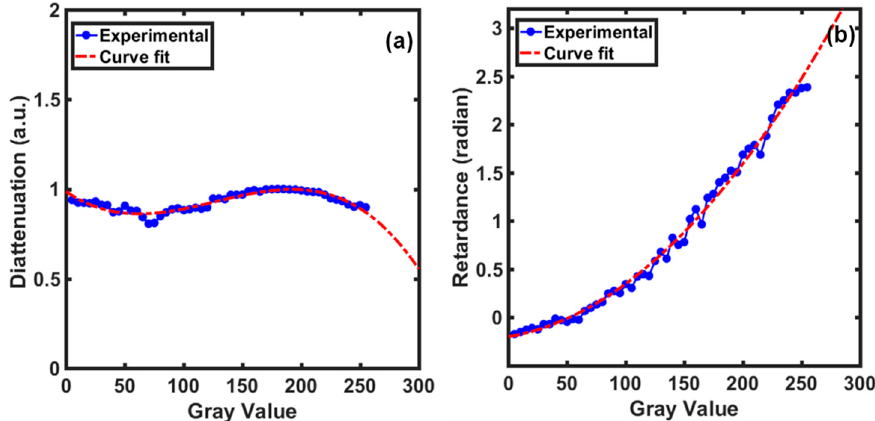
Figure 8. ( a ) Diattenuation and ( b ) retardance curves within grayscale range (0–255) of the SLM. Red dotted line represents the optimized curve fit (3rd-order polynomial) for the experimental data.